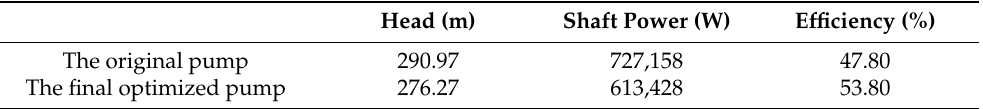
Table 14. Comparison of the hydraulic performance of the original and final optimized pump in the rated solid-liquid two-phase